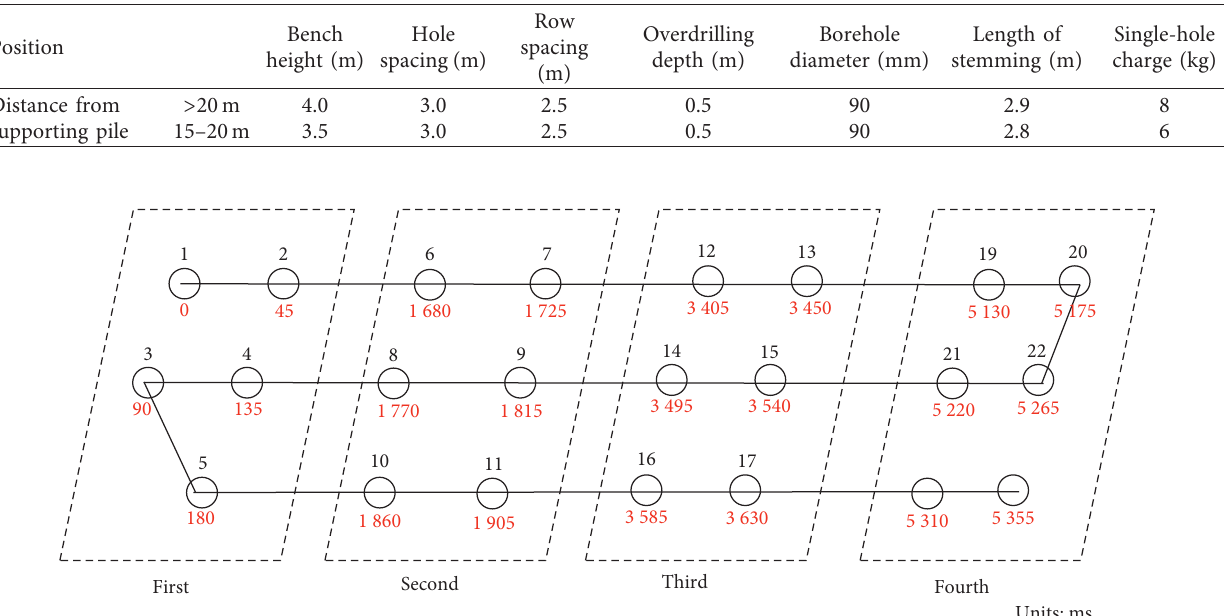
Figure 1: Surrounding environment of the experimental site: (a) the real picture and (b) the profile picture. Table 1: Parameters for blasting.